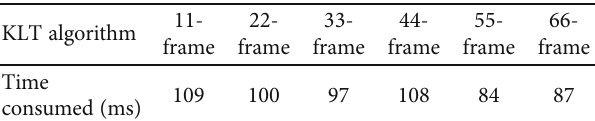
Table 4: Time consumption statistics of the KLT tracking